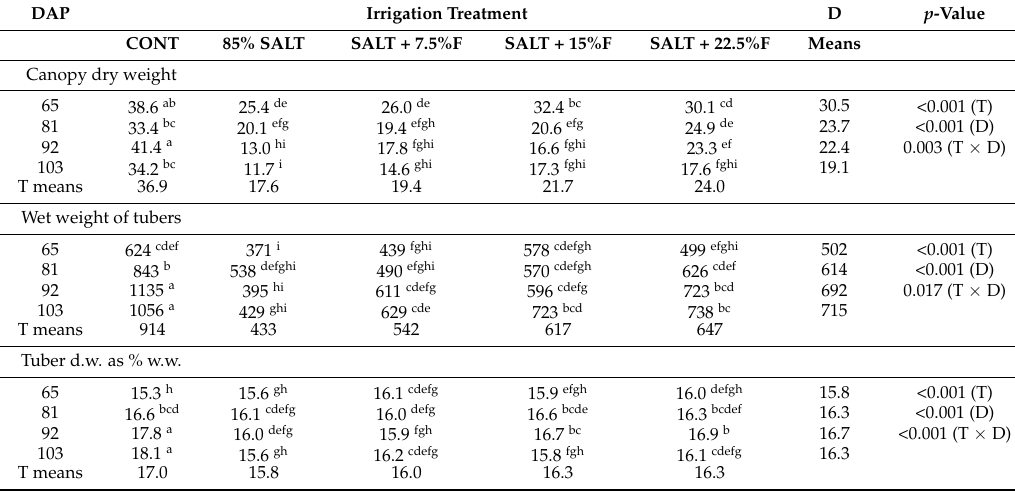
Table 1. The effects of irrigation treatment (T) and harvest date (D), specified as DAP, on canopy dry weights (g/pot) and tuber wet weight (g/pot) and wet to dry weight ratio (%).